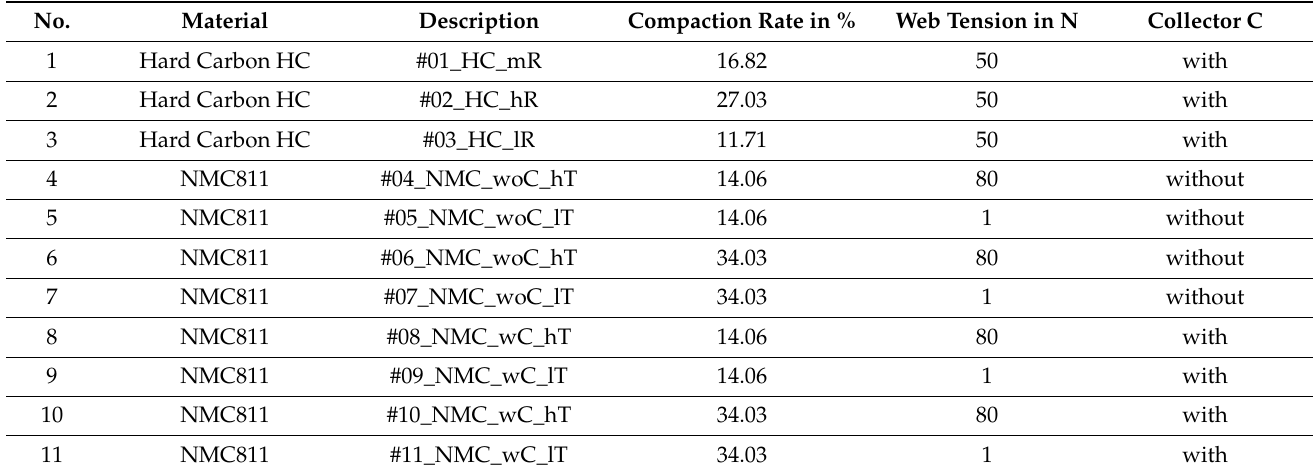
Table 1. Overview of the design of experiments.